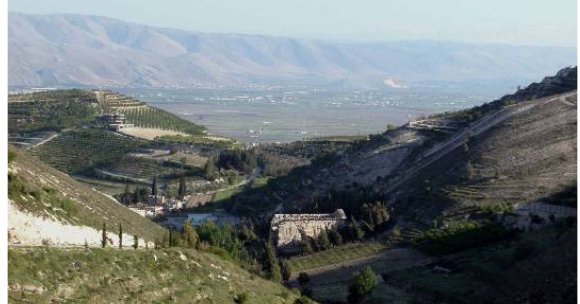
Figure 4. The sanctuary and village of Niha over the Beqaa Valley. © J. Yasmine; May 2003.